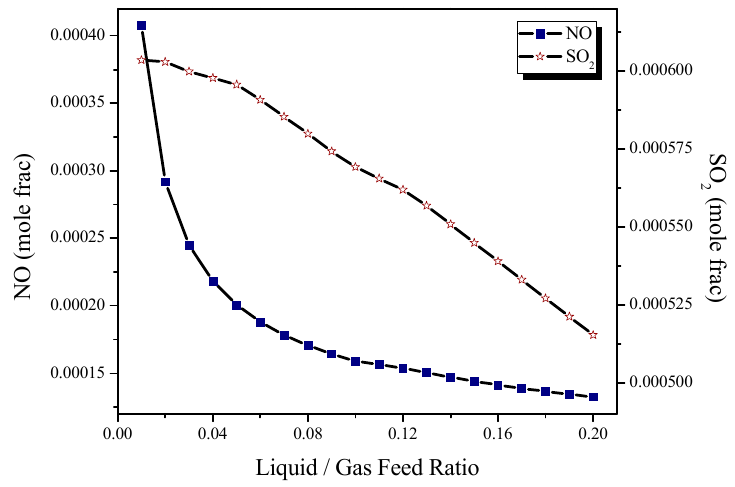
Figure 7. Effect of liquid / gas feed ratio on vapor product composition.